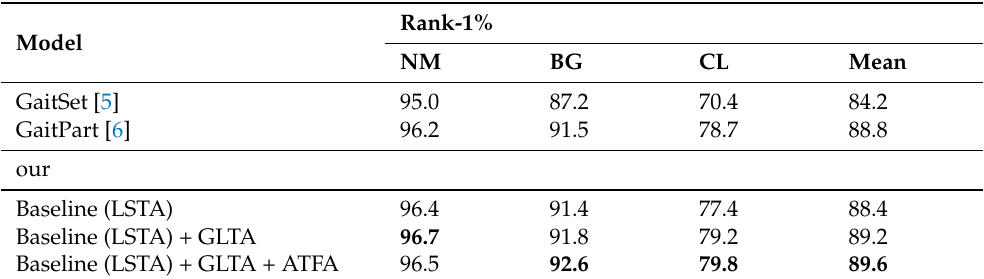
Table 5. Ablation experiments on CASIA-B [20] (50 persons, 11 view angles under 3 conditions), excluding identical-view cases. The bolds indicate the best accuracy in this state.